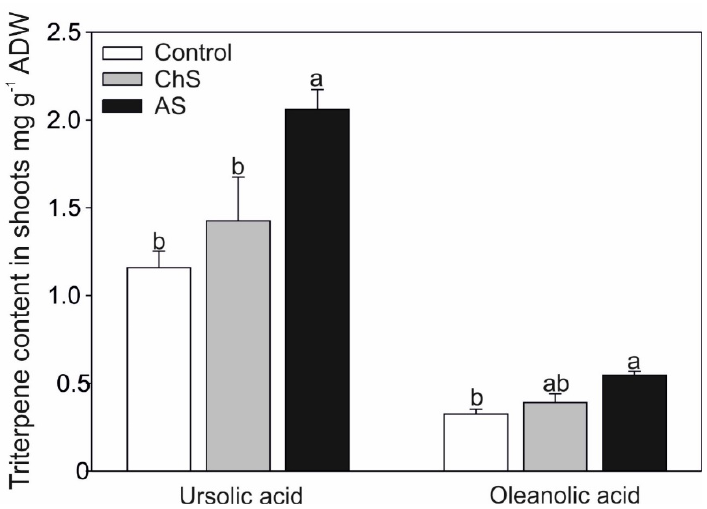
Figure 5. Effect of long-term chronic cadmium stress (ChS, 0.1 µM Cd, 85 days) or short-term acute cadmium stress (AS, 10 µM Cd, 4 days) on ursolic and oleanolic acids content in the shoots of C. acaulis . Data are means ± SE ( n = 5); values followed by the same letter are not significantly different ( p < 0.05, Tukey’s test).